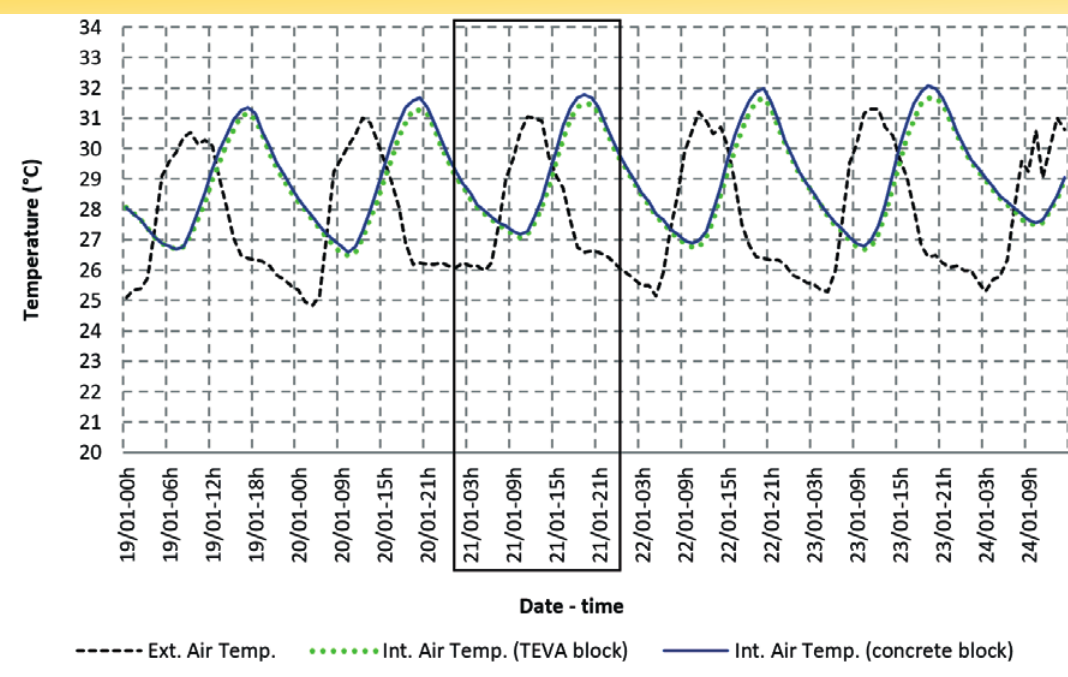
Comparison between the prototypes with green roofs with concrete blocks and with TEVA